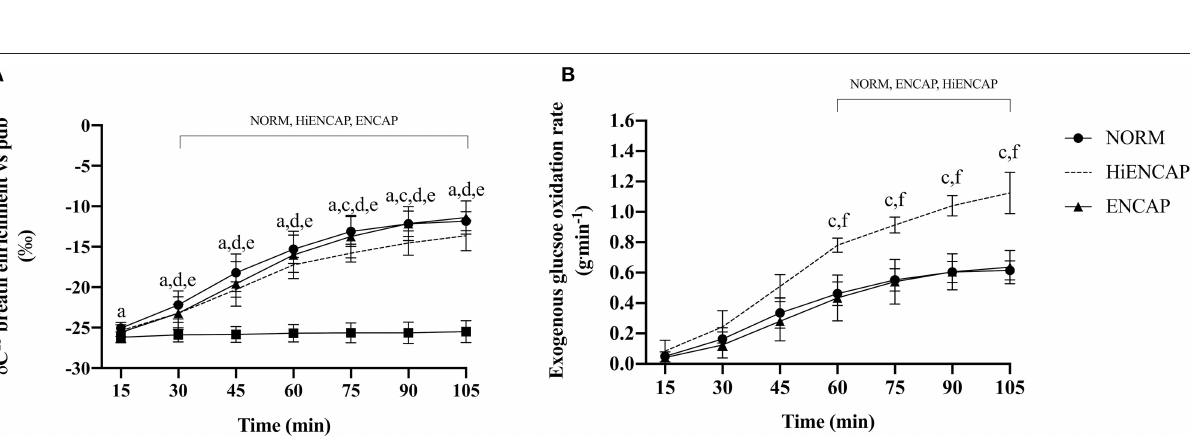
13 CO 2 enrichment compared with WAT. NORM demonstrated a at 75 and 90 min. There were no other significant